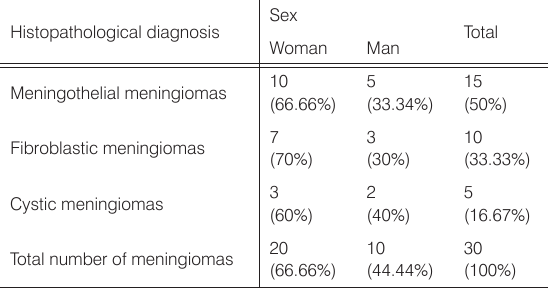
Table 2. Distribution of patients compared to histopathological diagnosis and age Histopathological